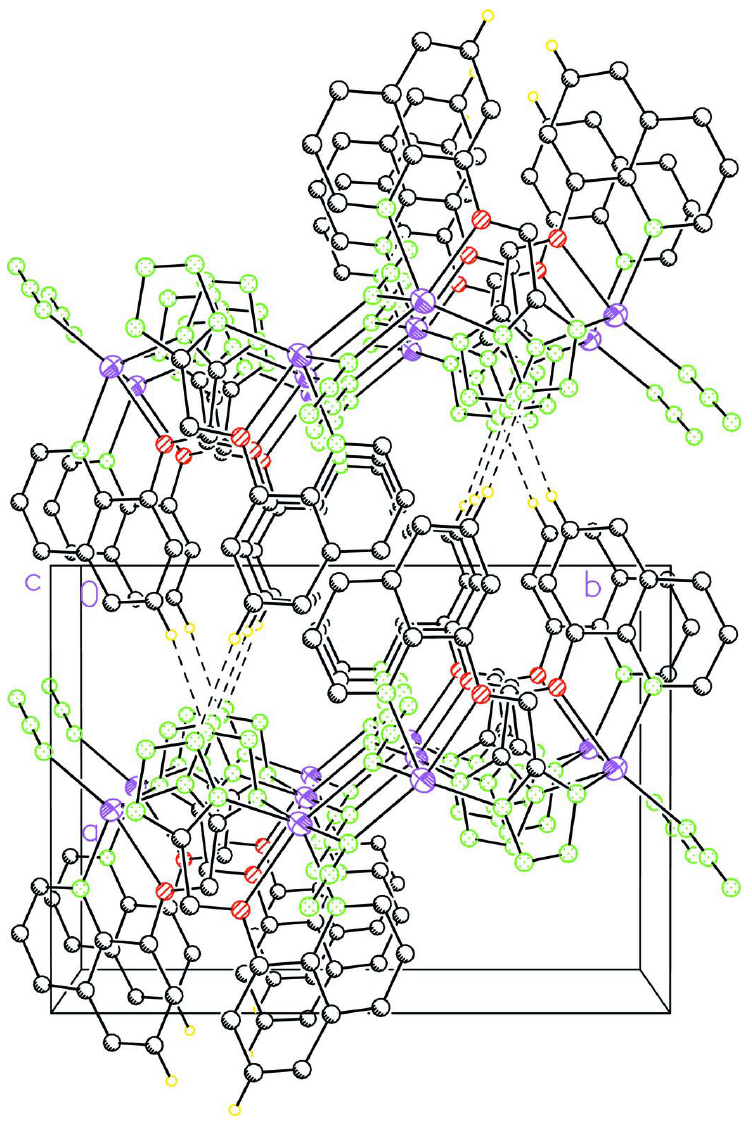
Crystal packing of the title compound viewed along the c axis. Hydrogen atoms not included in intermolecular hydrogen bonds are omitted for clarity. Dashed lines show the intermolecular hydrogen